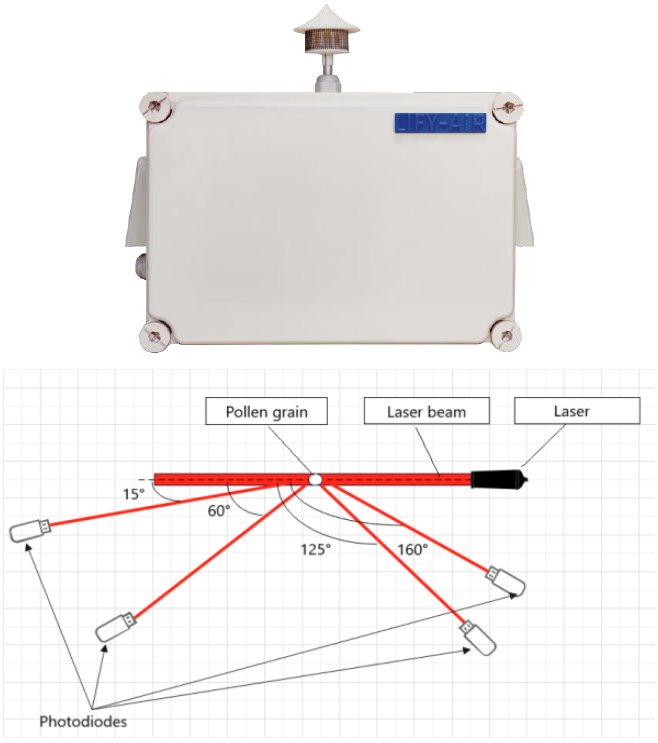
Figure 1. The Beenose sensor, with a picture of the instrument (top panel) and principle of measurement (lower panel).